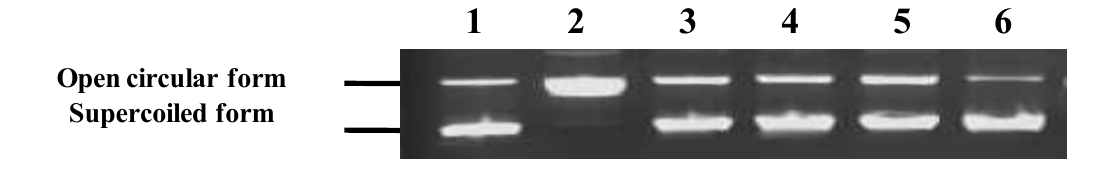
Figure 3. Inhibition of DNA damage by NJE. Lane 1, plasmid DNA (pBR322); Lane 2, DNA + 2,2′-azobis(2-methylpropionamidine) dihydrochloride (AAPH); Lane 3, DNA + AAPH + 5 μg extract; Lane 4, DNA + AAPH + 10 μg extract; Lane 5, DNA + AAPH + 15 μg extract; Lane 6, DNA + AAPH + 10 μg